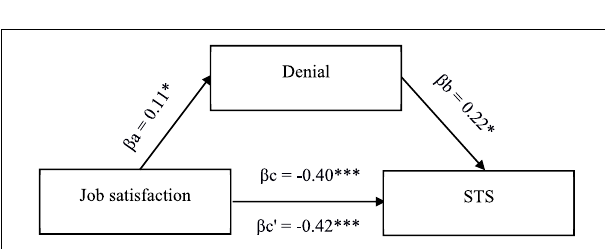
FIGURE 2 | Model of associations between job satisfaction, cognitive coping strategy in the form of denial, and STS. β a,b, indirect effect; β c, total